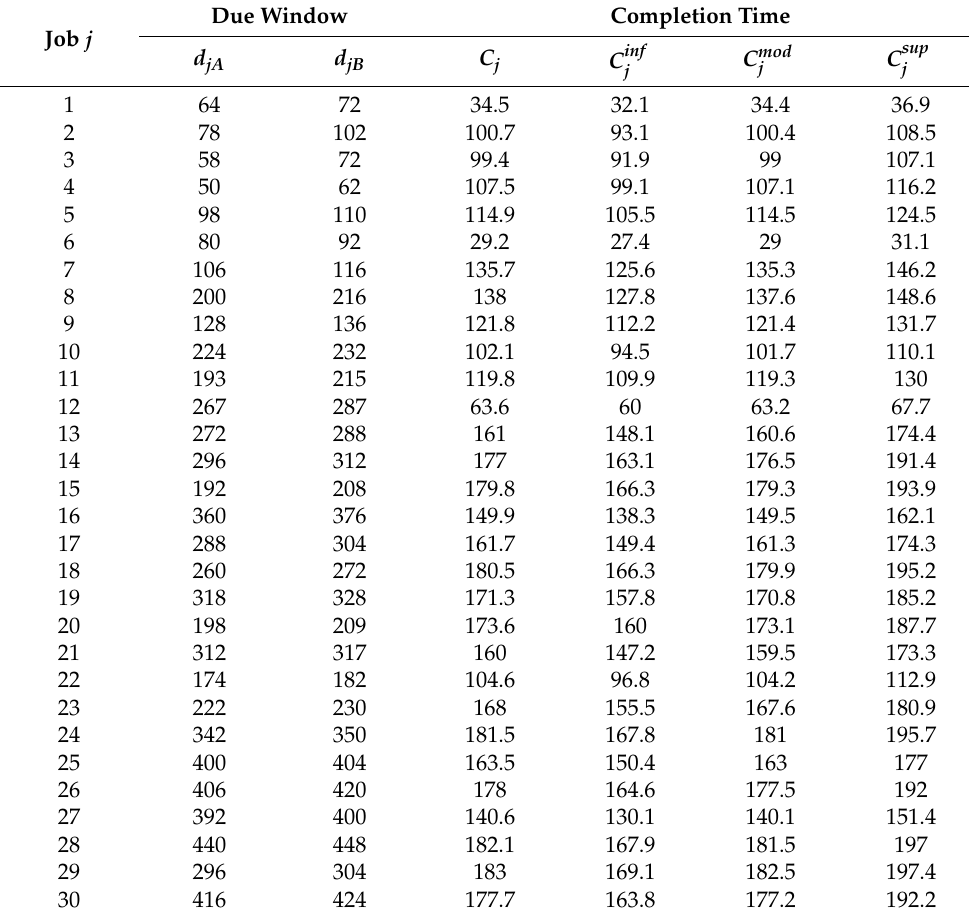
Table 4. Completion time for the best solution considering 30